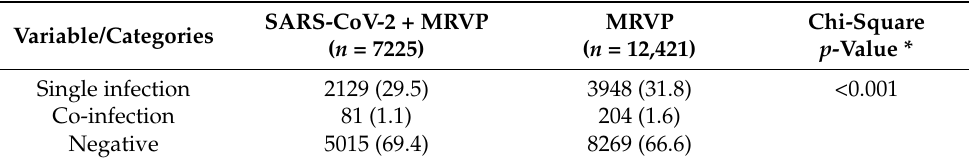
Table 3. Single infections and co-infections identified among specimens tested by (i) SARS-CoV-2 + MRVP and (ii) by MRVP